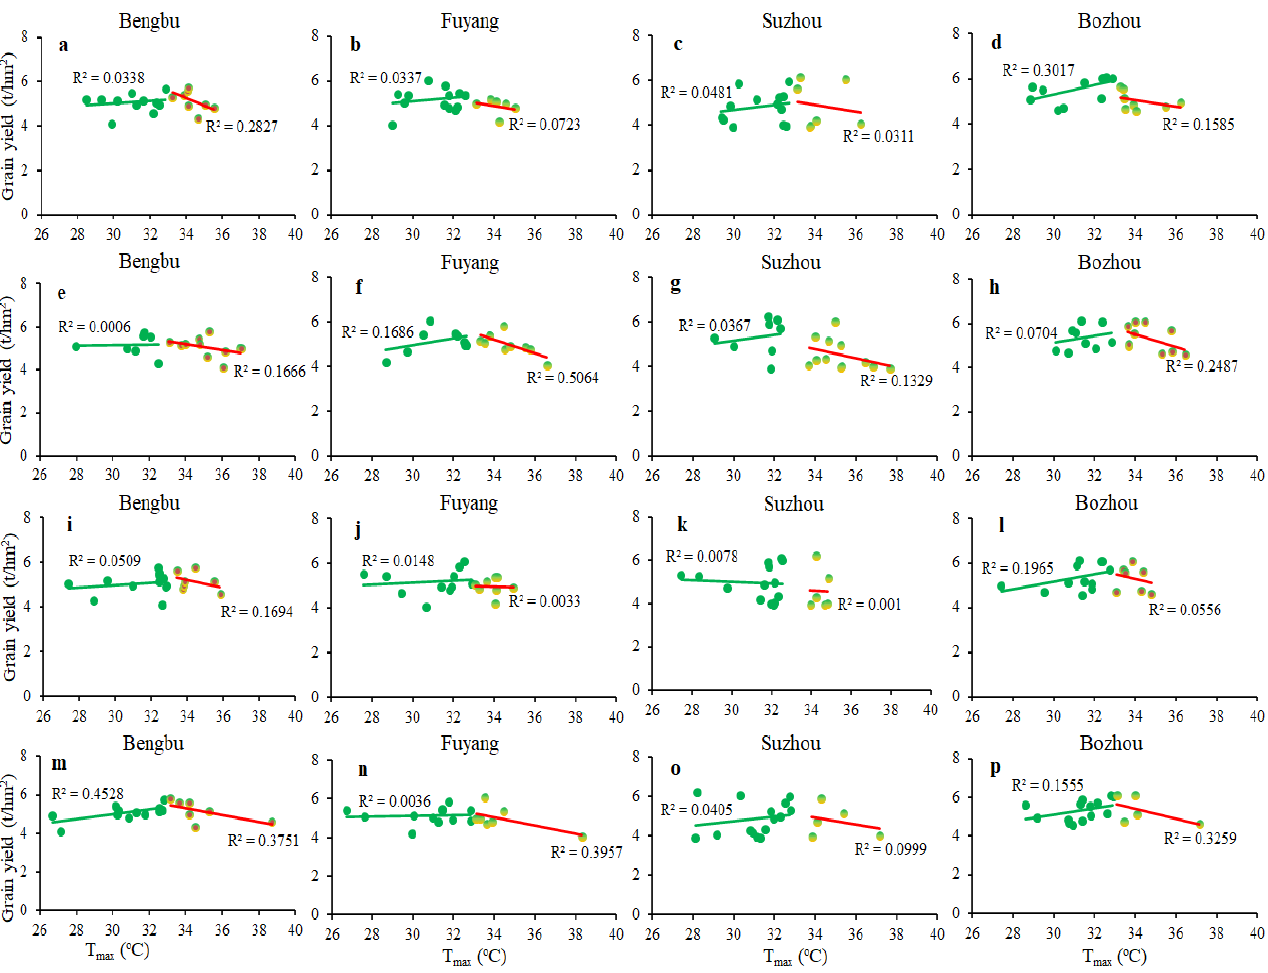
Figure 6. The relationship and linear fitting between maize grain yield and T max during flowering stage, including four phases, i.e., pre-anthesis (from 15 to 24 July, top subfigure layer), anthesis (from 25 to 31 July, upper-middle subfigure layer), silking (from 1 to 7 August, lower-middle sub- figure layer), and post-silking (from 8 to 15 August, bottom subfigure layer) at four sites, i.e., Bengbu